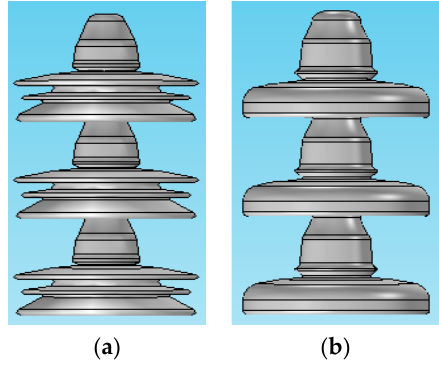
Figure 1. Schematic diagram of the wind tunnel laboratory.